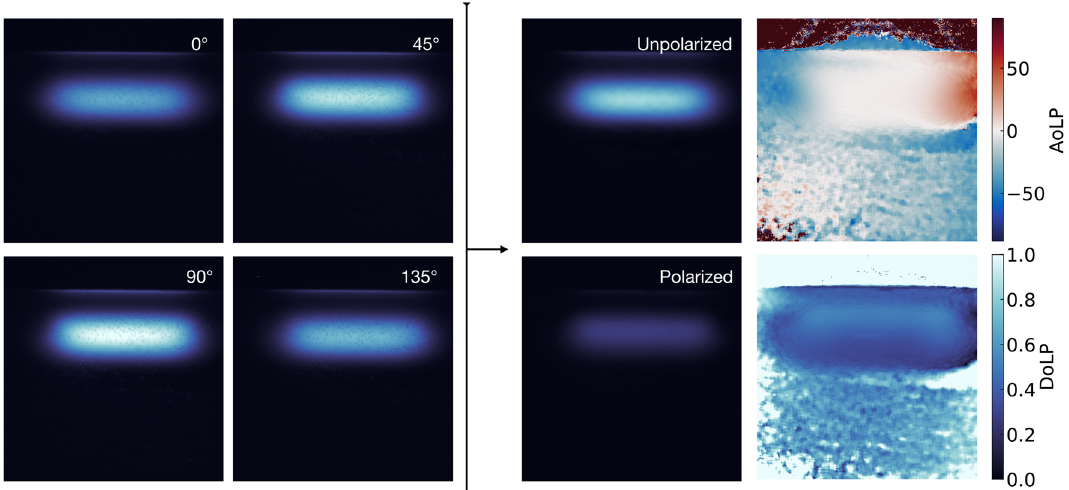
Figure 6. On the left are presented the four images acquired from the four polarization states (0 ◦ , 45 ◦ , 90 ◦ , 135 ◦ ) for a 6 MeV beam. The right panel presents the resulting images following the polarization imaging formalism. The unpolarized and polarized portions of the signals are presented along with the degree and angle of linear polarization extracted from each